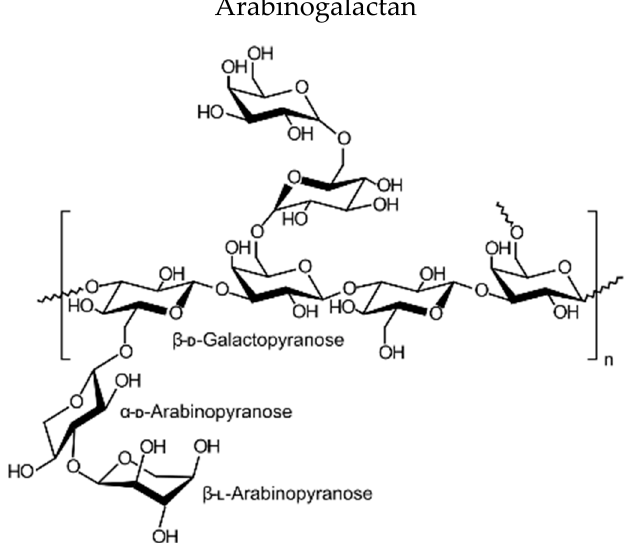
Figure 7. Structural formulas of polysaccharides.